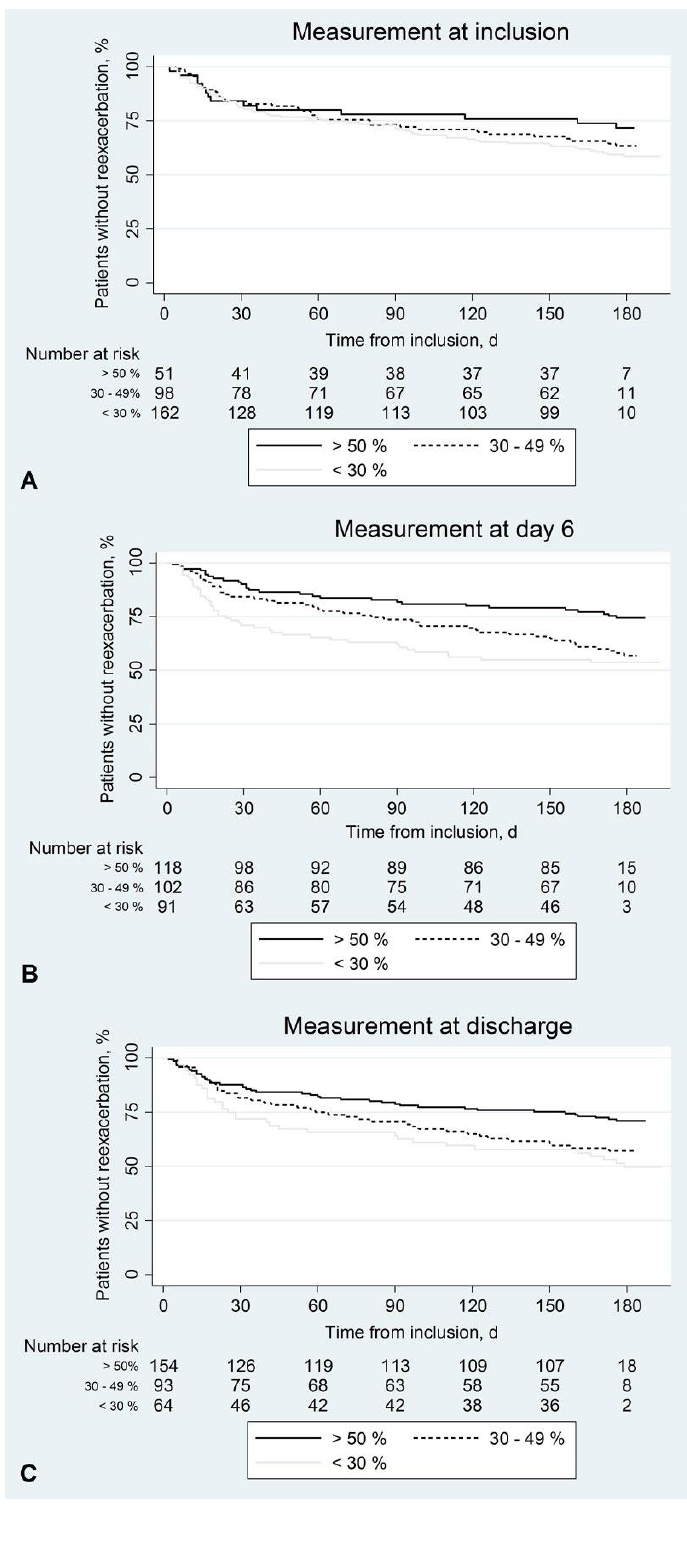
Figure 2: Survival curves according to forced expiratory volume in 1 second (FEV 1 ) at base- line, day 6 and discharge. Proportions of patients without re-exacerba- tion during follow-up for different categories of FEV 1 in % predicted (<30%, 30–50%, >50%): (A) at inclusion (p(log rank test) = 0.31), (B) at day 6 (p = 0.003) and (C) at dis- charge (p =